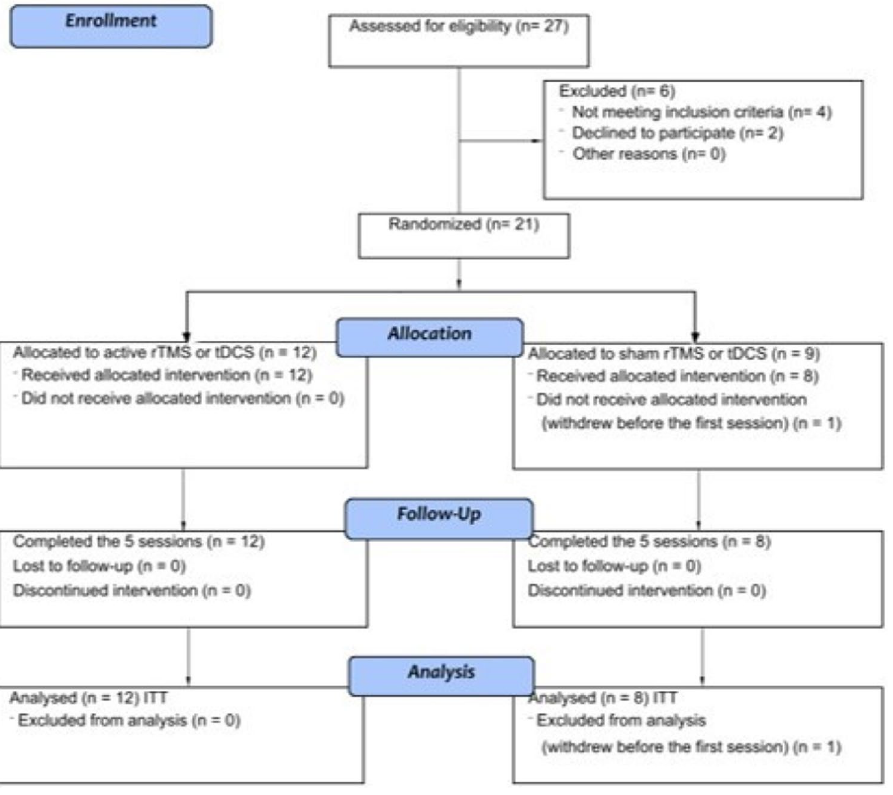
Figure 2. Patient disposition and CONSORT flowchart. ITT